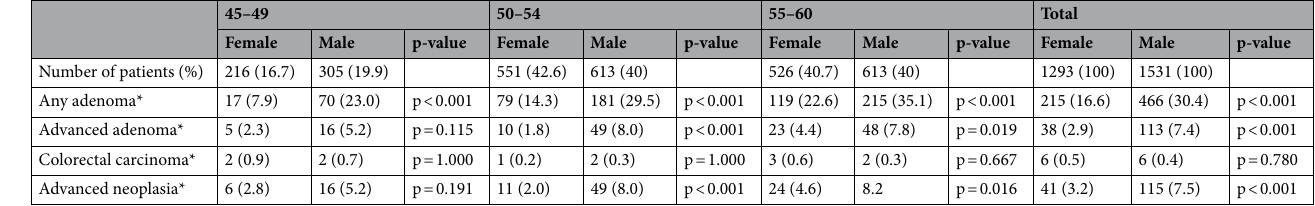
Table 2. Sex and age specific colonoscopy findings. Crude event rates stratified for sex and age. *Numbers expressed as total number of patients, percentage in